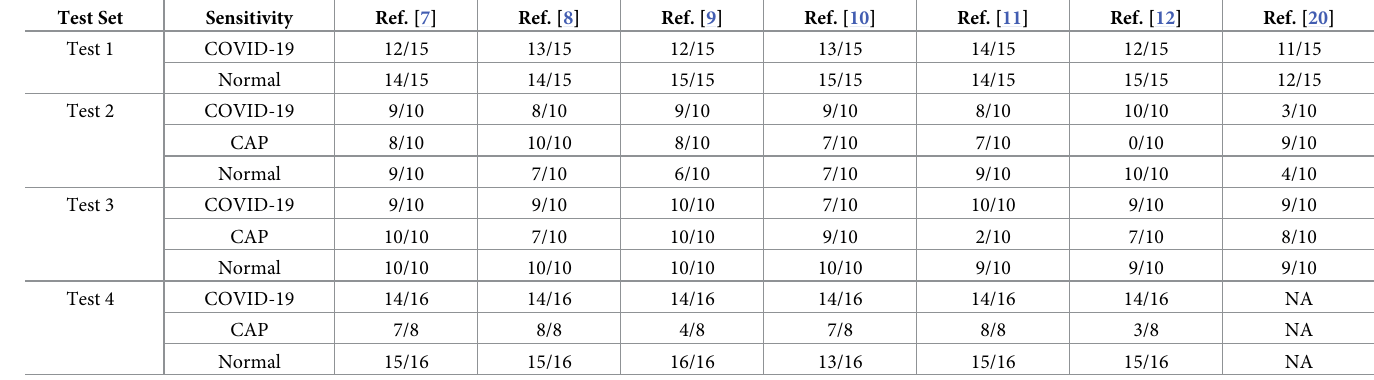
Table 7. The ratio of correctly classified cases over total cases in each class obtained for the top six models that were developed based on the SPGC-COVID dataset following the Signal Processing Grand Challenge (SPGC) on COVID-19 diagnosis. Test Set